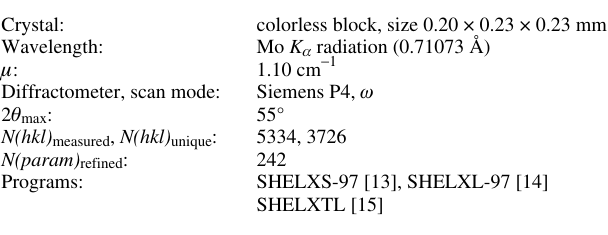
Table 1. Data collection and handling.